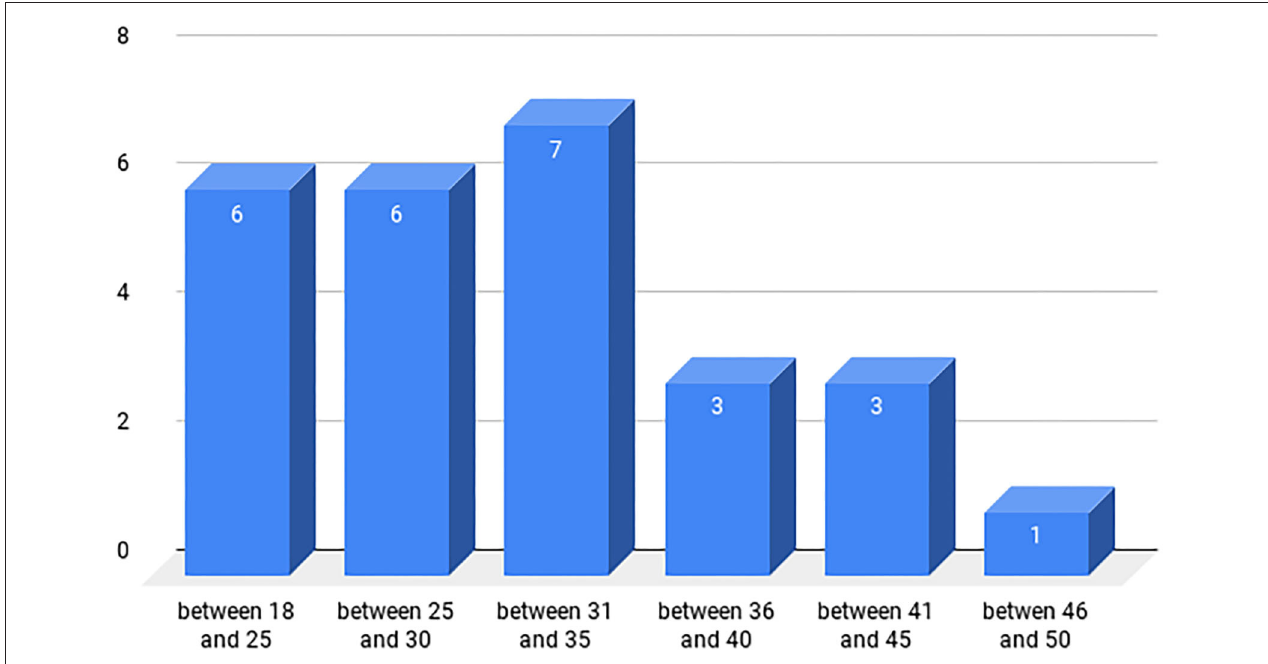
FIGURE 2 | Ages of science